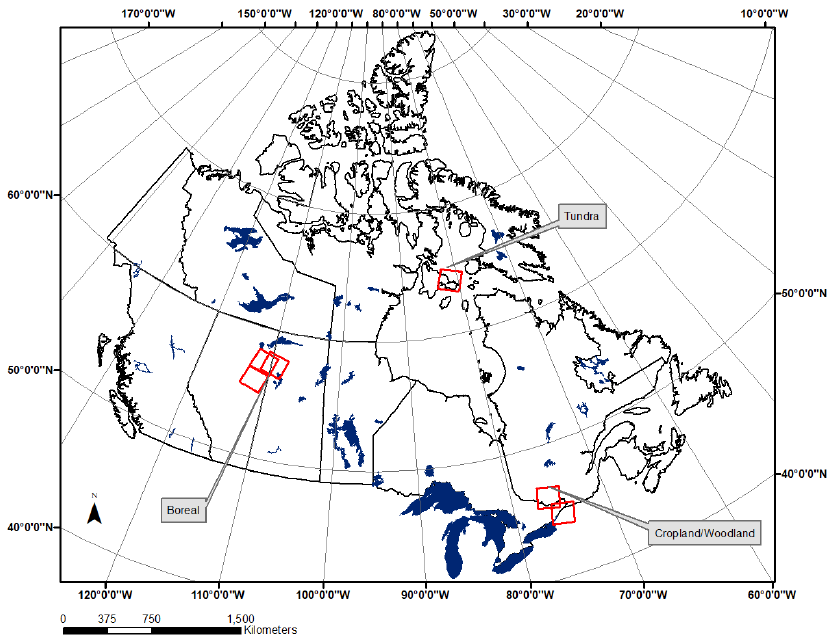
Figure 1. Study site locations and Landsat scene footprints.